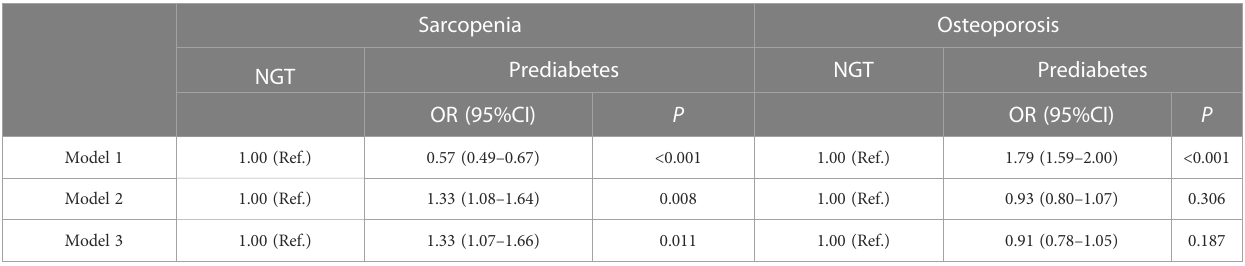
TABLE 2 Association between prediabetes and the odds of sarcopenia and osteoporosis.